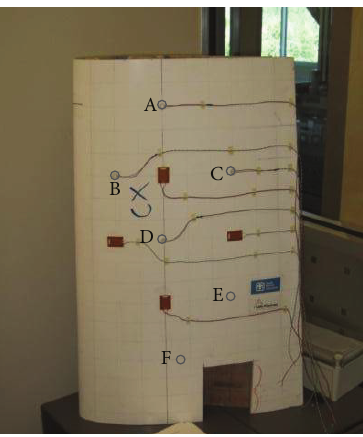
Figure 1: Turbine blade